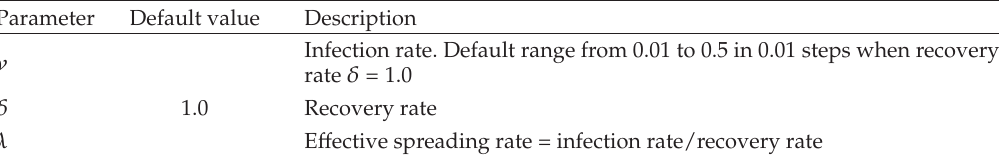
Table 1: Epidemic parameters.